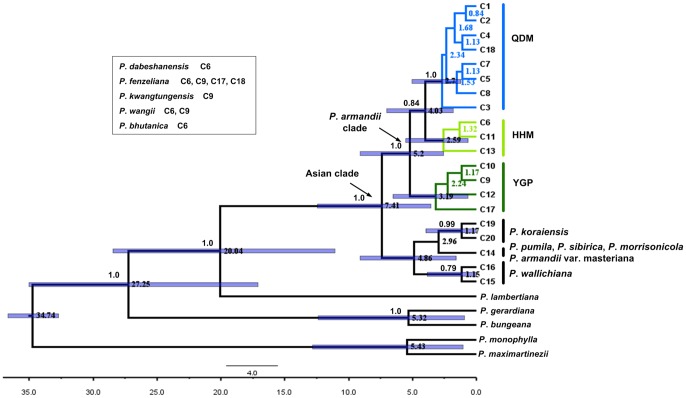
Phylogenetic chronogram of the chlorotypes generated from BEAST.Numbers above the branches indicate the Bayesian posterior probabilities greater than 0.5. Median ages of nodes are shown, with horizontal bars indicating the 95% highest posterior density intervals. The other species included in the Pinus armandii clade are shown in the box.